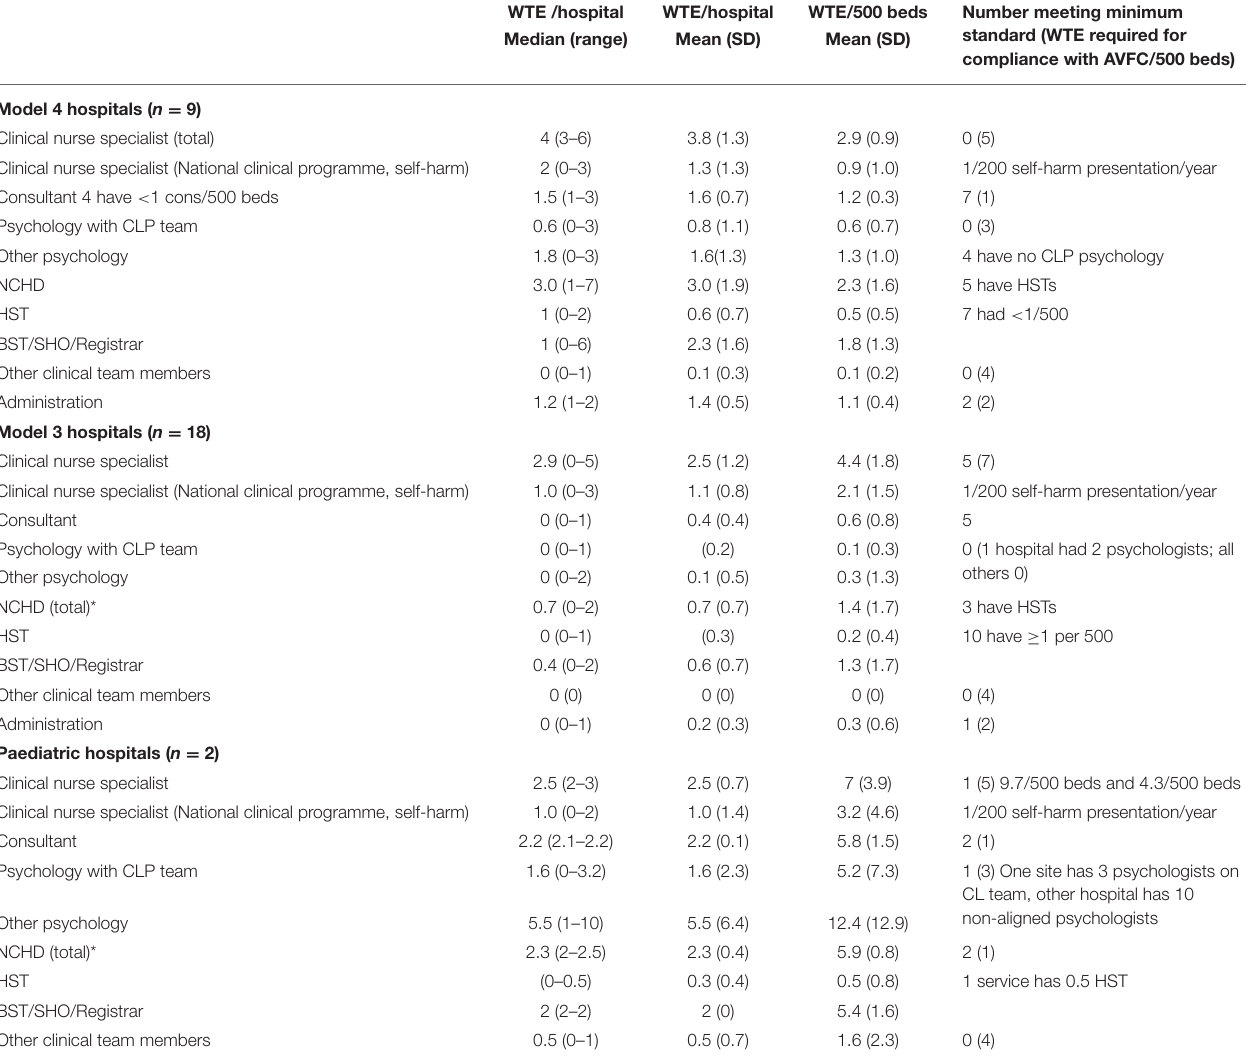
TABLE 3 | Staffing at Model 3, Model 4 & Paediatric hospitals in Ireland in absolute numbers and per 500